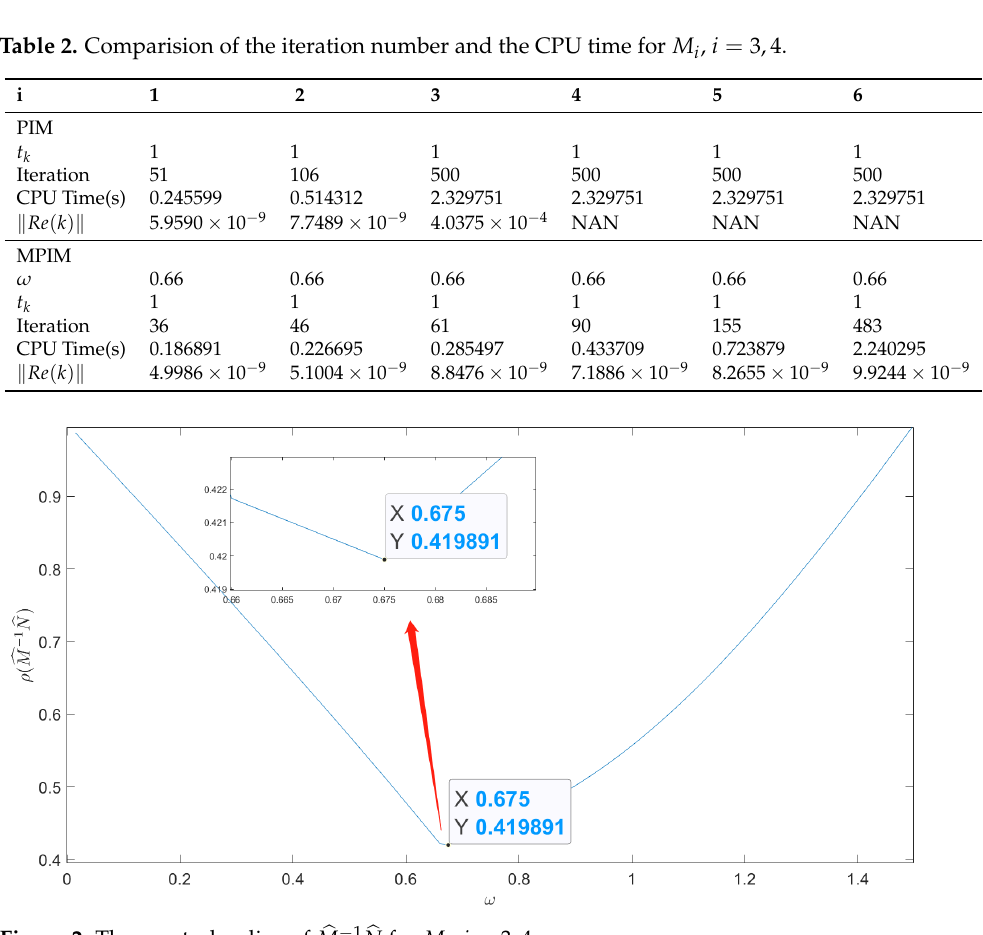
Figure 2. The spectral radius of (cid:98) M − 1 (cid:98) N for M i , i =